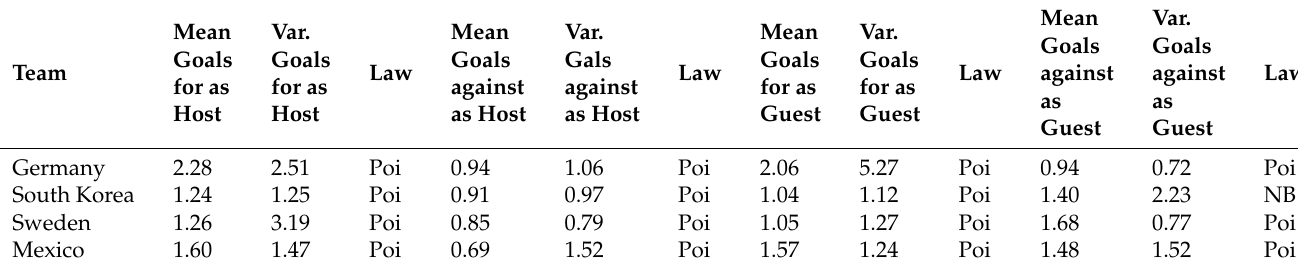
Table 11. Group F in Russia 2018.